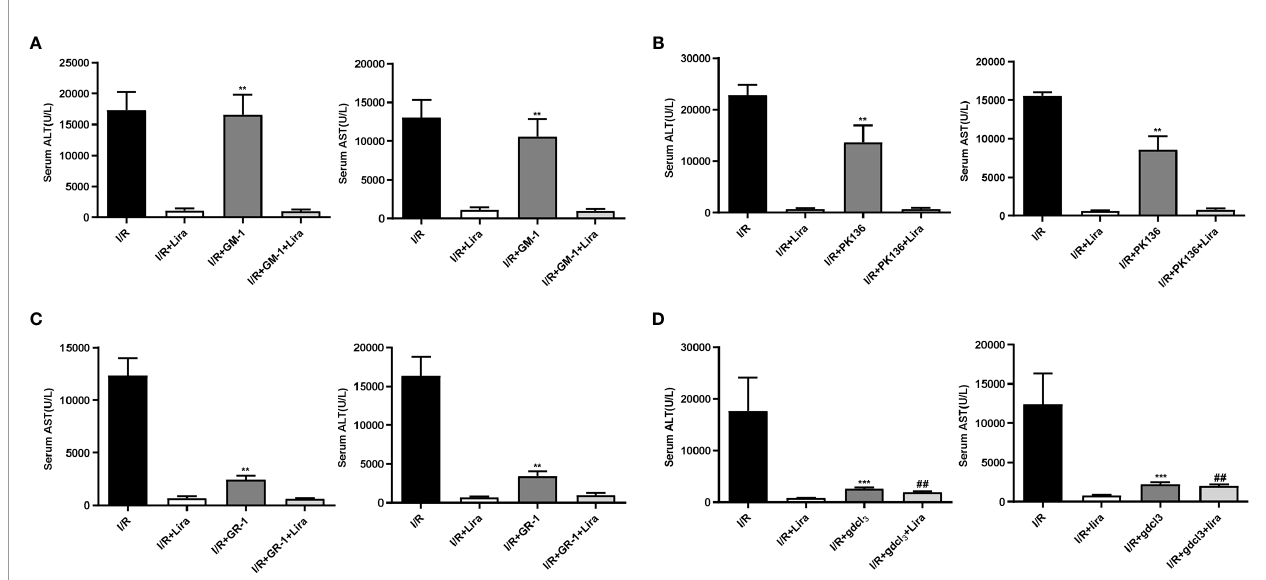
FIGURE 3 | The protective effect of liraglutide on hepatic IRI may be realized through its action on macrophages. NKs, NKTs, neutrophils, and macrophages were eliminated before liver IRI. Serum ALT and AST levels of each group after NK (A) , NKT (B) , neutrophil (C), and macrophage (D) depletion. Similar results were obtained from at least three independent experiments. Data are shown as mean ± SD, n = 3 – 6 per group. **P < 0.01, ***P < 0.001 vs. the I/R+Lira group; ## P < 0.01 vs. the I/R+Lira group. NKs, natural killer cells; NKTs, natural killer T